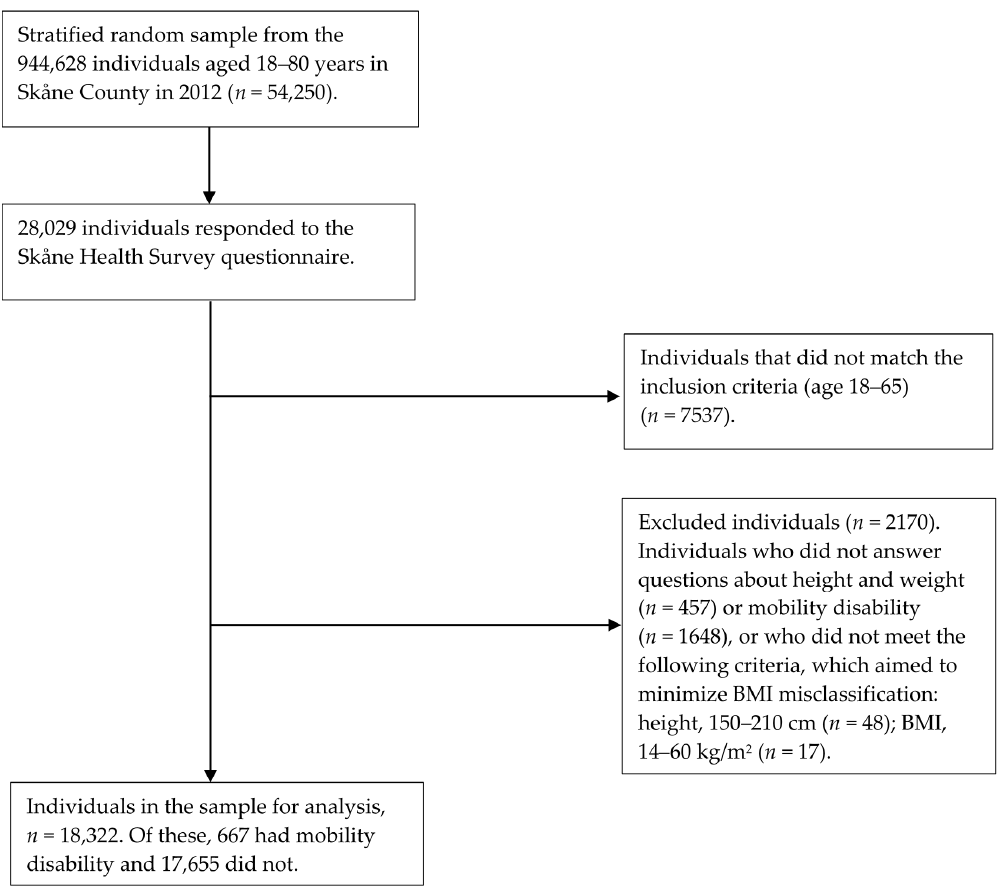
Figure 1. Flowchart for participating individuals in the Skåne Public Health Survey 2012. BMI: body mass index.